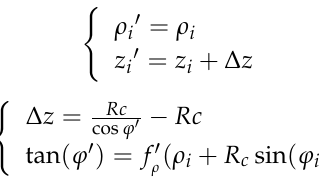
9 of 21 Figure 8. Normal direction compensation method and tool path analysis: ( a ) Tool path; ( b ) Tool path projection; ( c ) X axis motion; ( d ) Z axis motion. Therefore, a modified tool radius compensation method is proposed as shown in Figure 9. In the Z direction compensation method, the tool tip only needs to shift along the Z direction until the